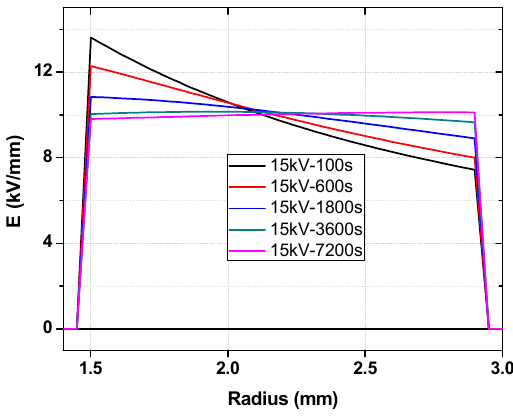
Figure 9. Modeled field distribution profiles in a cable sample with a temperature gradient of 10 ◦ C at an applied voltage of 15 kV.